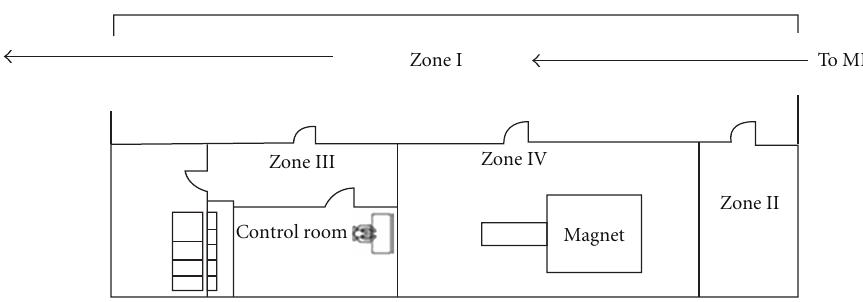
Figure 3: Floor plan of the MRI facility of the hospital.